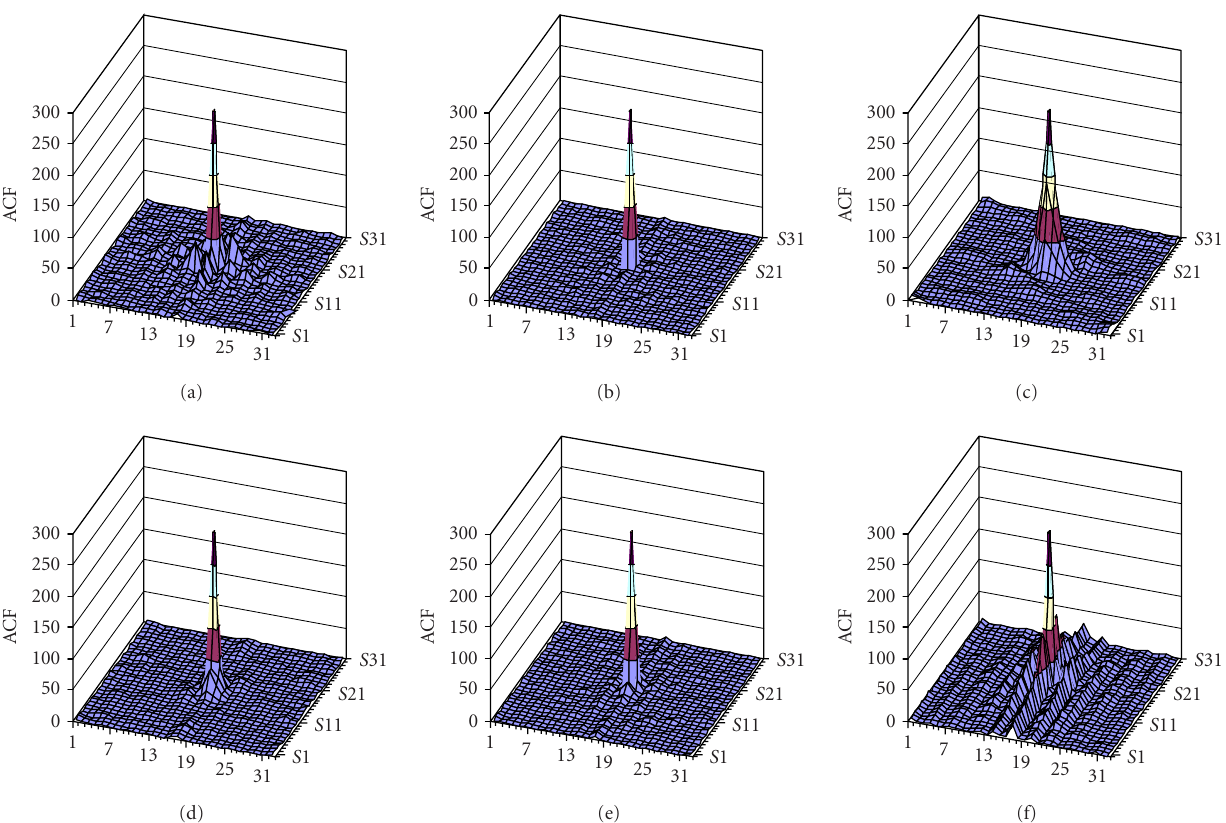
Figure 4: Three-dimensional representation of the right-upper texture fragment ACF (32 × 32): (a) noise-free, (b) corrupted by Gaussian multiplicative noise with σ 2 µ = 0 . 012, and after processing the image by (c) the 5 × 5 median filter, (d) the 5 × 5 modified sigma filter, (e) the 5 × 5 local statistic Lee filter, and (f) the 8 × 8 DCT-based filter. correspond to noise. Thus, the texture, irrespective of its spa- tial spectral characteristics, is preserved well and noise is ef- fectively